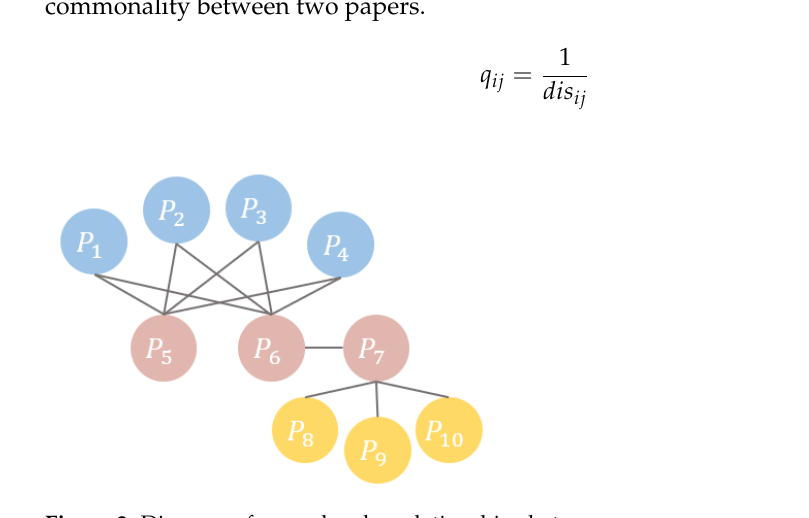
Figure 3. Diagram of second-order relationships between resources.